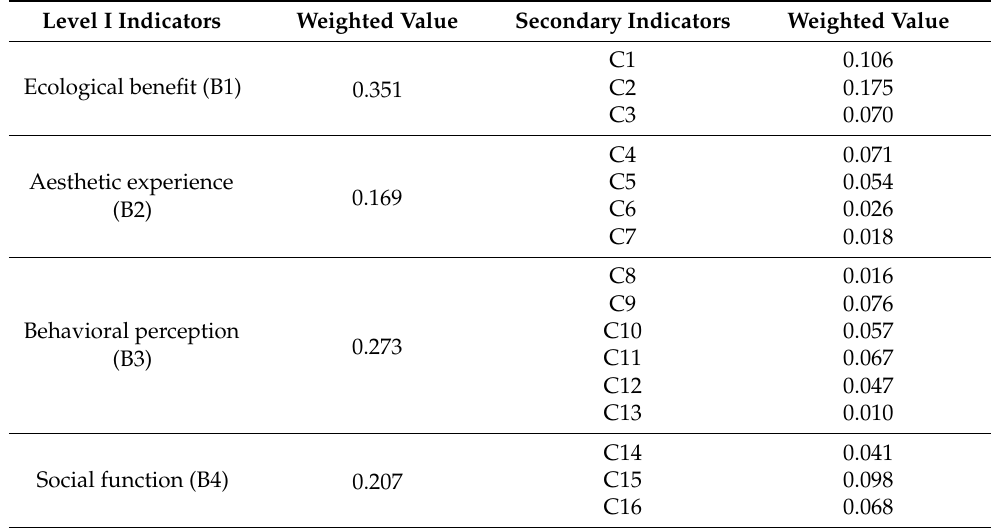
Table 1. Quality assessment framework of the urban, mountainous ecological